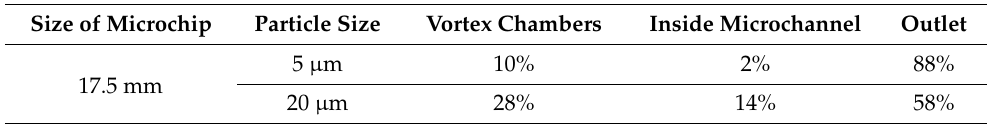
Figure 10. Numerical simulation of Sollier’s microchip [1]. ( a ) Dimensions the geometry; ( b ) Velocity streamlines inside microchip. Table 3. Particle capture rate of Sollier’s